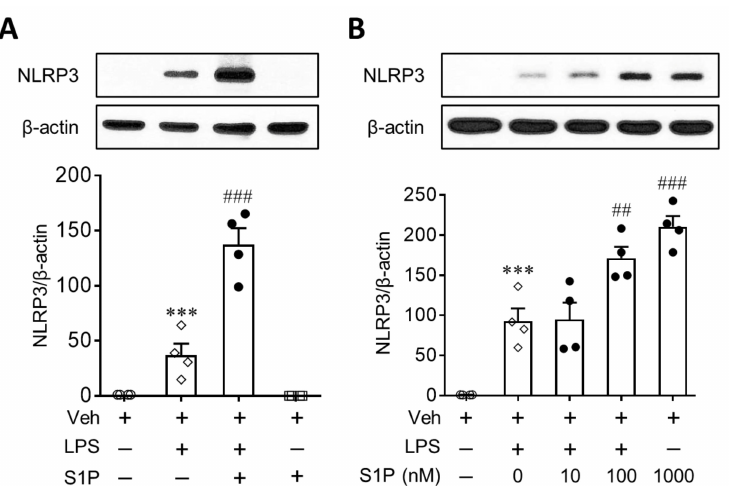
Figure 1. S1P enhances NLRP3 upregulation in LPS-primed BMDMs. Cells were treated with LPS (500 ng/mL) for 4 h and then exposed to S1P (1 µ M) for an additional 1 h. In some cases, cells were exposed to S1P for 1 h without priming with LPS. ( A ) Effects of S1P on NLRP3 expression in BMDMs in the presence or absence of LPS were analyzed by Western blot. ( B ) Concentration-dependent effects of S1P (0.01, 0.1, and 1 µ M) on NLRP3 expression in LPS-primed BMDMs were analyzed by Western blot. n = 4 per group. *** p < 0.001 versus control BMDMs (Veh). ## p < 0.01, and ### p < 0.001 versus LPS-primed